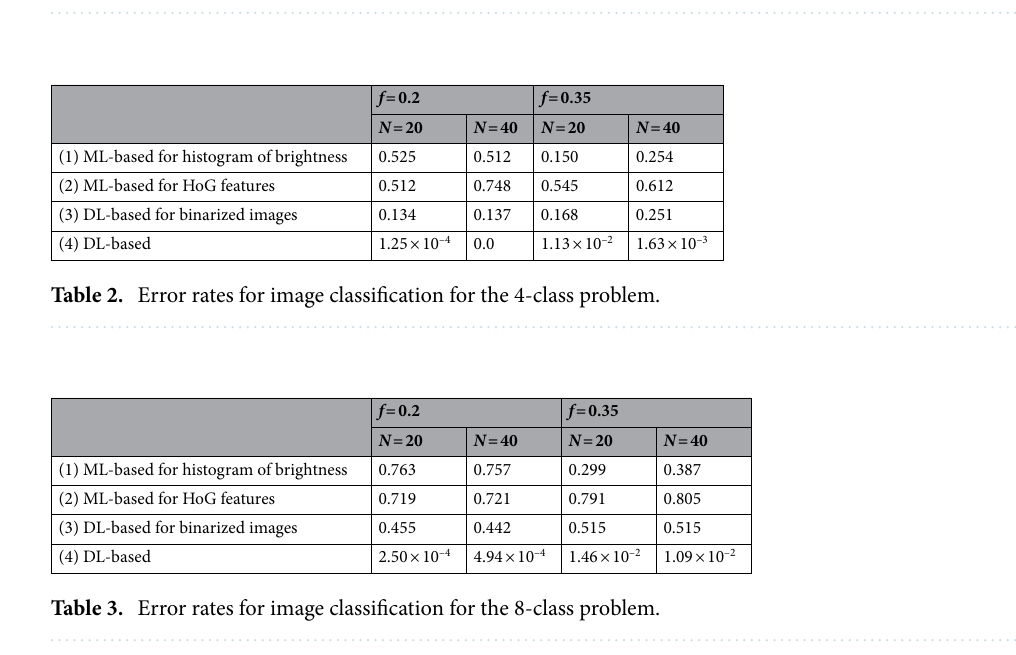
Table 1. Confusion matrices of the 4-class problem at 100 epochs.